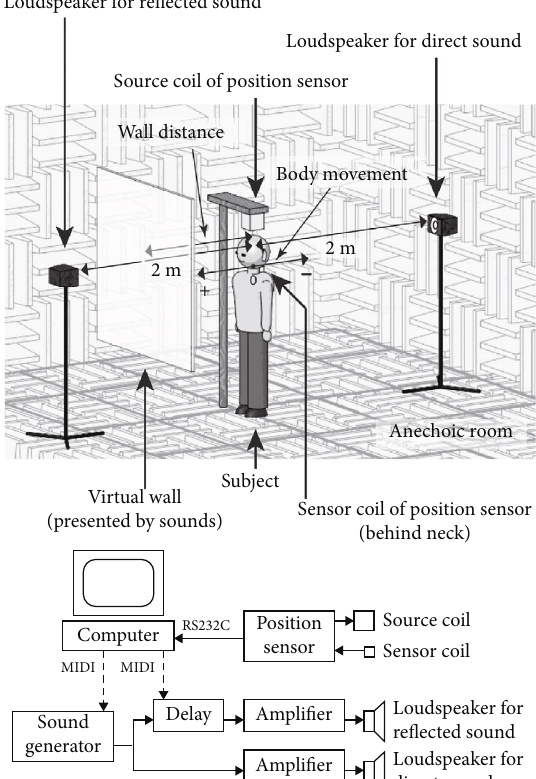
Figure 1: Schematic of the experimental setup: arrangement of loudspeakers, position sensor, and participant in anechoic room and a block diagram of the audio equipment, position sensor, and